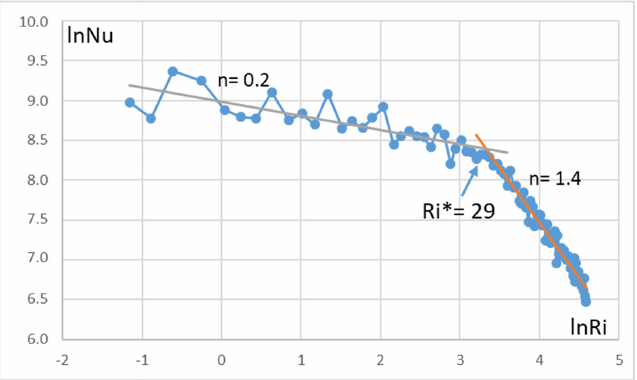
Figure 17. Dependence of ln(cid:1840)(cid:1873) on ln(cid:1844)(cid:1861) in the experimental run with ∆(cid:1845) (cid:3036)(cid:3041)(cid:3036)(cid:3047)(cid:3036)(cid:3028)(cid:3039) = 30 ppm and (cid:1844)(cid:1857) = 214 . (cid:1829) (cid:2870) = 13 for the asymptote at (cid:1844)(cid:1861) > (cid:1844)(cid:1861) ∗ .